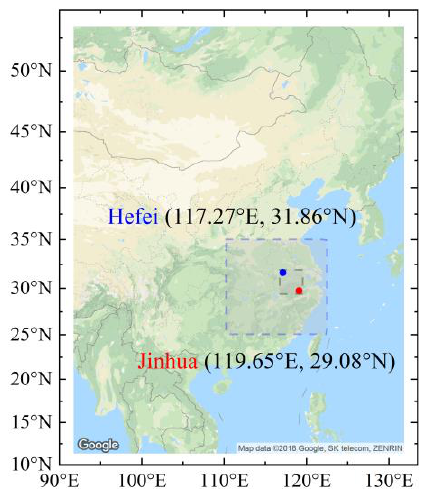
Figure 1. The region defined in this study is shaded by a rectangle with dashed lines. The two lidar observation sites are marked with the blue dot (Hefei) and red dot (Jinhua), respectively. The smaller rectangle is used in Figure 7c.